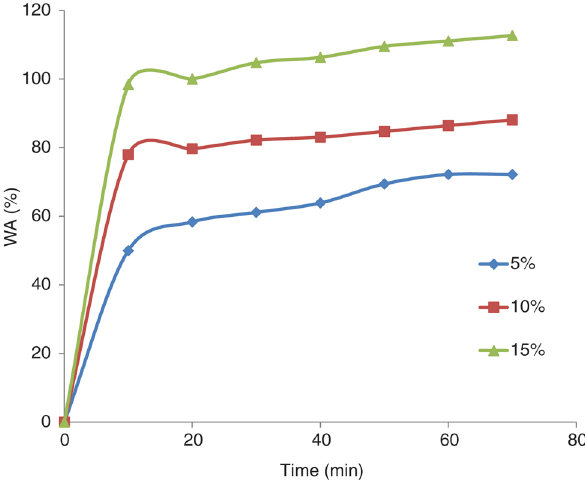
Figure 12: WA for samples without epoxy coating.